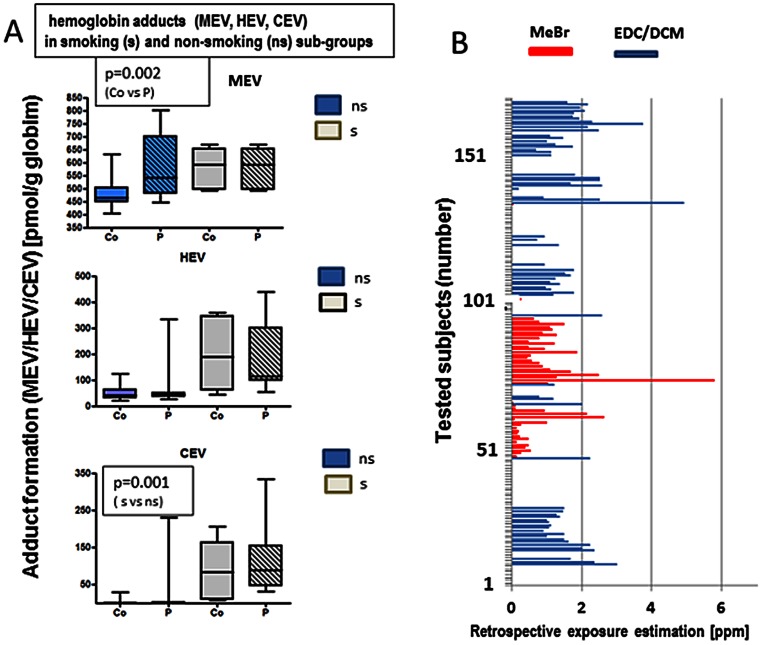
Exposure assessment in subjects with presumed intoxication with halo-alkane-based pesticides (fumigants).A. Formation of hemoglobin adducts: MEV (upper panel), HEV (middle panel), CEV (lower panel) in smoking (s) and non-smoking subgroups (ns). The data are shown as box plots indicating the minimum, the 25-percentile, the 75-percentile values; the medians are shown as a cross line. Blue boxes show non-smoking subgroups (ns) while the grey ones represent smoking subgroups (s); for both subgroups (s, ns) the empty boxes show data for the non-exposed controls (Co), the boxes with the dashed lines show exposed individuals (P). B. Retrospective exposure estimated for all tested subjects with presumed intoxication to methyl- or ethyl halide pesticides. As described in the methods, the exposure was weighted from the human biomonitoring data and expert valuation of the job history and clinical data. The lines show calculated exposure values to methyl bromide (red) or ethylene dichloride/dichloromethane (blue). The concentrations are shown in ppm (mL/m3).